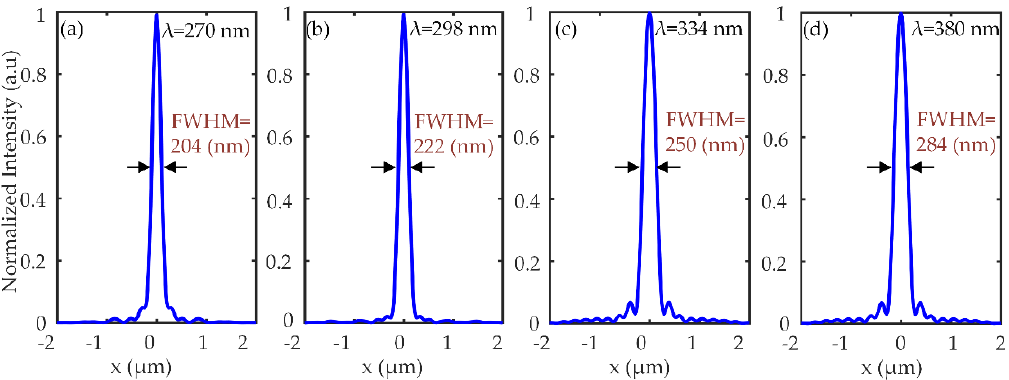
Figure 4. Normalized intensity profile of the focus spot along x-direction at respective wavelengths i.e., 270 nm, 298 nm, 334 nm and 380 nm. ( a ) y = 0, z = 5.3 µm, ( b ) y = 0, z = 4.6 µm, ( c ) y = 0, z = 4 µm and ( d ) y = 0, z = 3.1 µm.